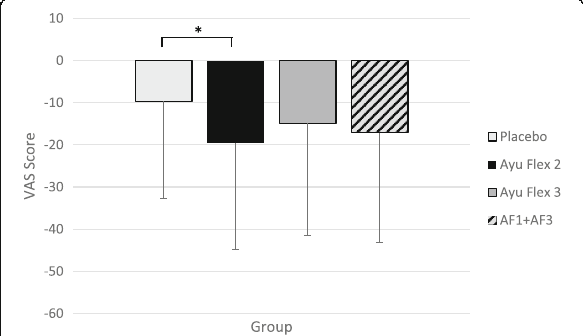
Fig. 11 Mean ± SD changes in reported levels of discomfort/pain following the 6-Minute Walk Test. A significant ( p = 0.048) difference was noted between AyuFlex 1 and the Placebo